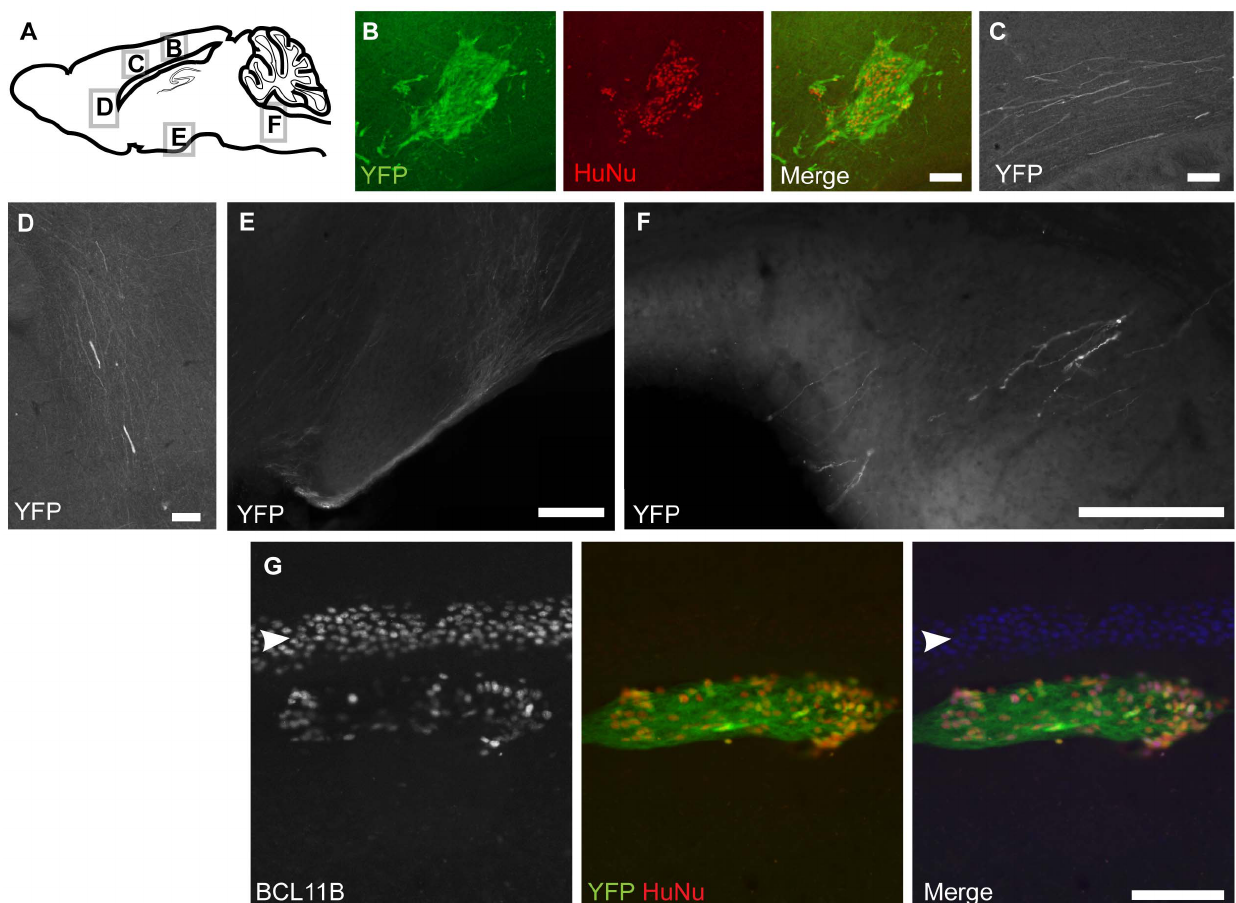
Figure 2. Human ESCs-derived Fezf2- YFP-expressing neurons extend axonal projections in the mouse brain at P90. ( A ) Schematic of sagittal mouse brain indicates the location of panels B–F. YFP + HuNu + cells were present in the injection site in the cortex ( B ), some YFP + axons were present in the white matter ( C, D ), at the base of the forebrain ( E ), and pyramidal decussation ( F ). ( G ) Transplanted h Fezf2 -YFP cells at the injection site in the deep layer of the cortex expressed the CSMN marker BCL11B. Mouse layer 5 neurons expressing BCL11B are indicated by white arrow. Scale bars: 100 m m (B, C, F, G); 200 m m (D, E).